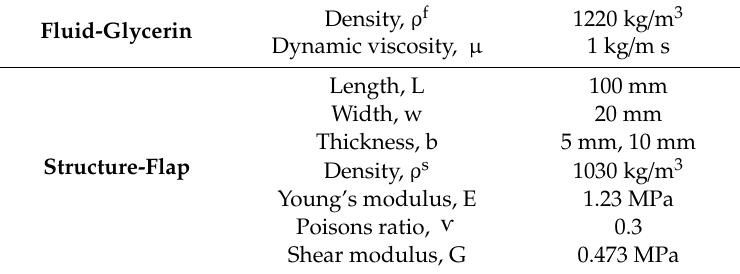
Table 1. Engineering parameters and dimensions. Fluid-Glycerin